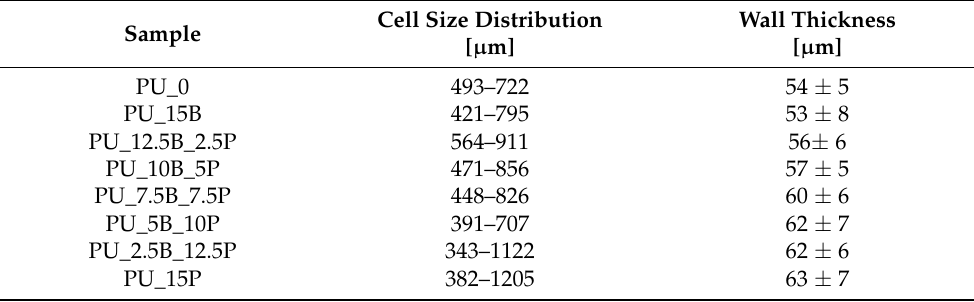
Table 2. Effect of buckwheat hulls and perlite on the structural parameters of rigid PU foams.